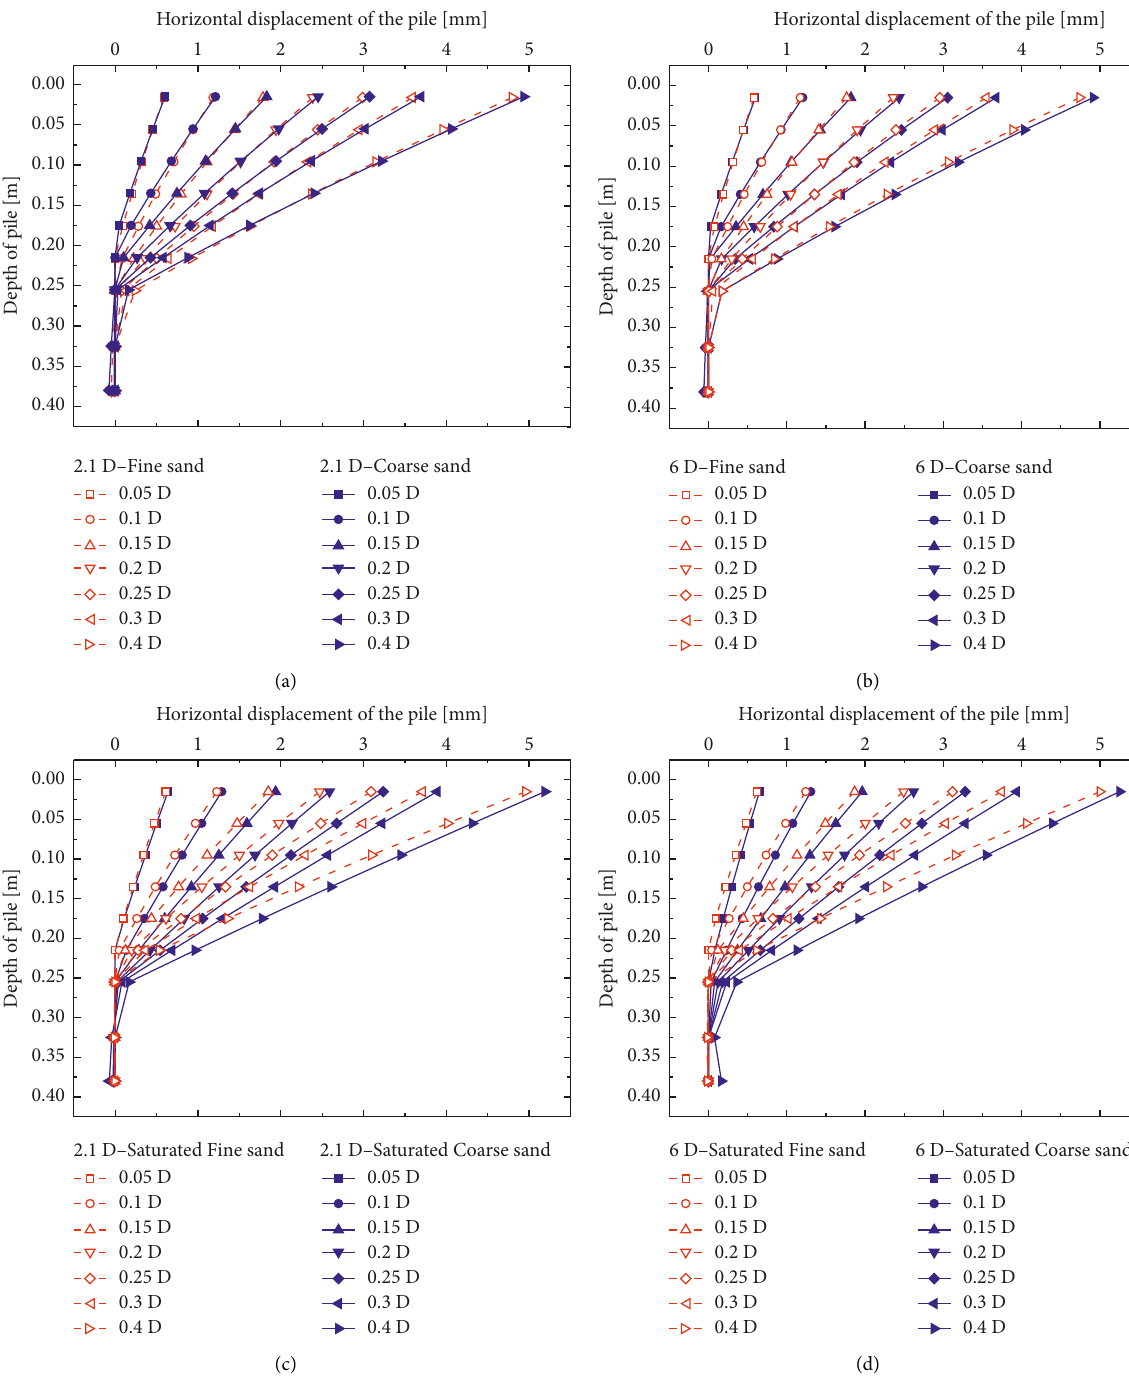
Figure 5: Comparison of pile displacement in fine sand and coarse sand. (a) 2.1D dry sand, (b) 2.1D dry sand, (c) 2.1D saturated sand, and (d) 6D saturated